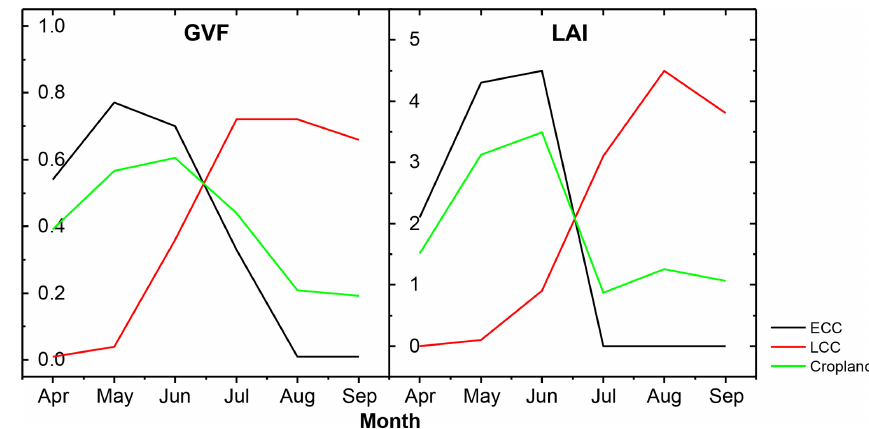
Figure 11. GVF and LAI dynamics of early-covering crops (ECC), late-covering crops (LCC) and